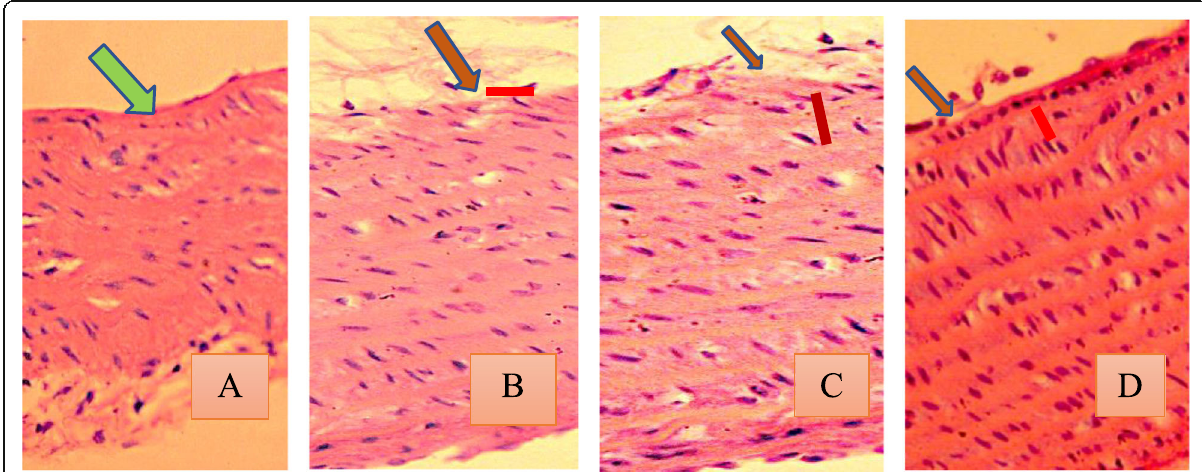
Fig. 8 Histopathology of aortic wall of normal and high-fat diet-fed rats treated with BFR and ATSN. a Normal aorta (magnification × 40). b High- fat diet fed (magnification × 40). c ATSN treated (magnification × 40). d BFR 200 mg/kg (magnification × 40). Green arrow and red arrow represent the normal and altered morphology of the aorta layer. Red thick line/bar represents the wall thickness of the aorta layer of normal and BFR, BFR + ATSN BFR treated